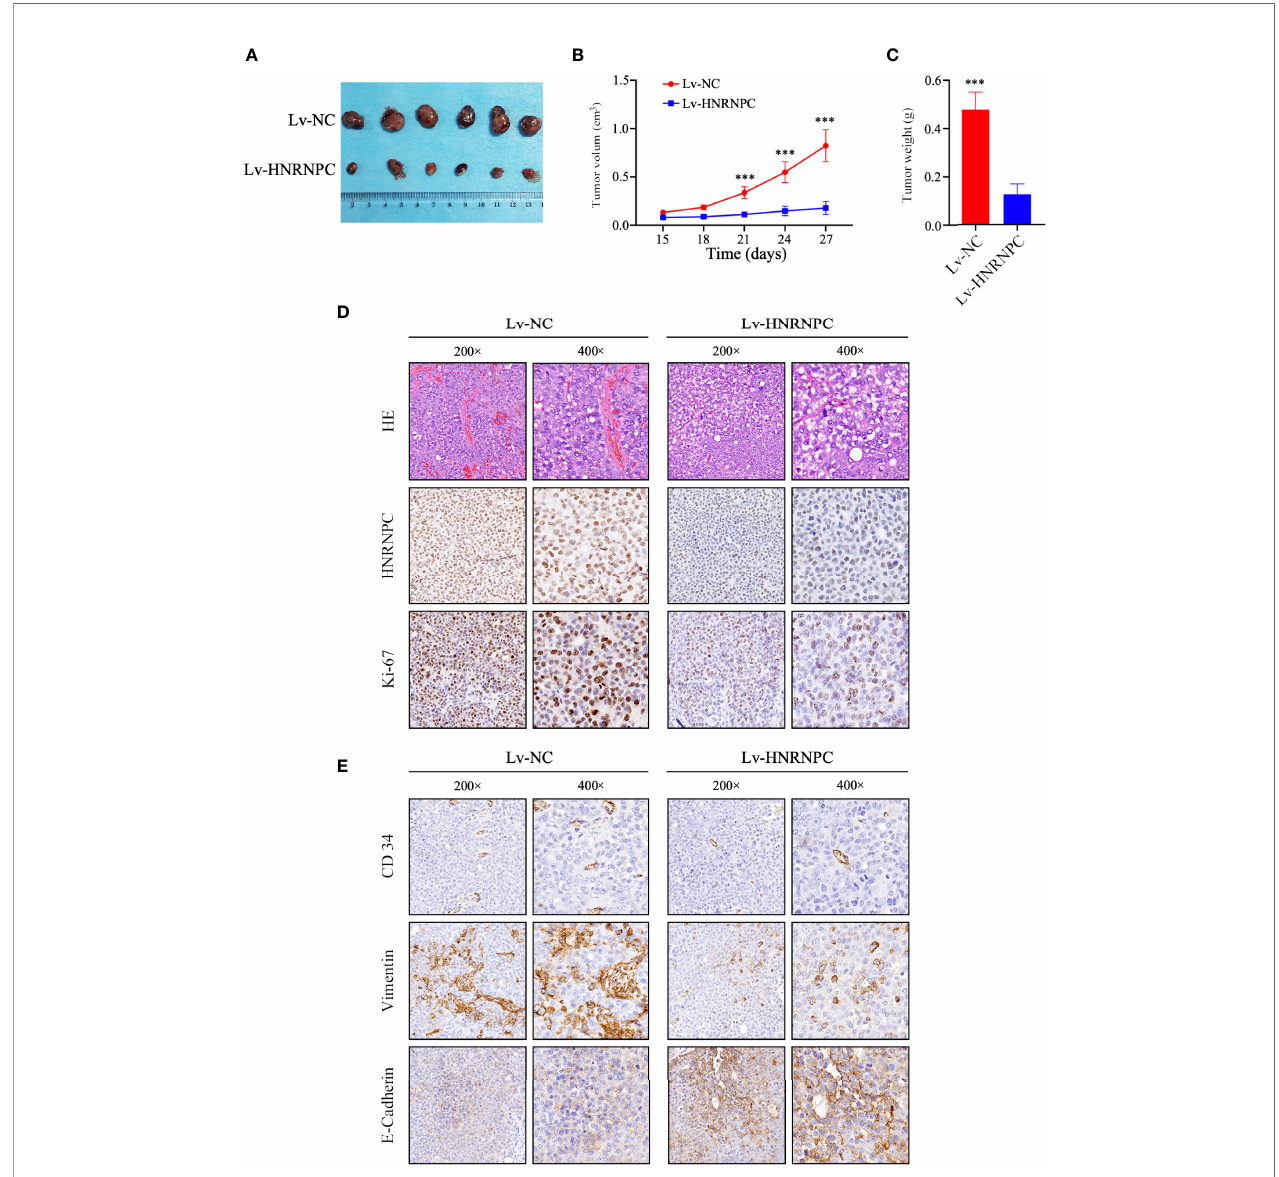
FIGURE 4 | HNRNPC knockdown blocked HCC cell proliferation in vivo . (A) Huh-7-cell xenograft tumors in Lv-HNRNPC and Lv-NC groups. (B, C) t-test analysis showing tumor weights and sizes in Lv-HNRNPC and Lv-NC Huh-7 cell groups. (D) H&E staining to con fi rm xenograft tumors (upper panel); IHC to detect HNRNPC levels in xenograft tumors (middle panel); proliferation of xenograft tumors as determined by Ki-67 staining (nether panel). (E) IHC staining to analyze CD34 (upper panel), Vimentin (middle panel), and E-Cadherin (nether panel) expression in xenograft tumors. The tumor size and weight were demonstrated as mean ± standard deviation (SD). ***P <